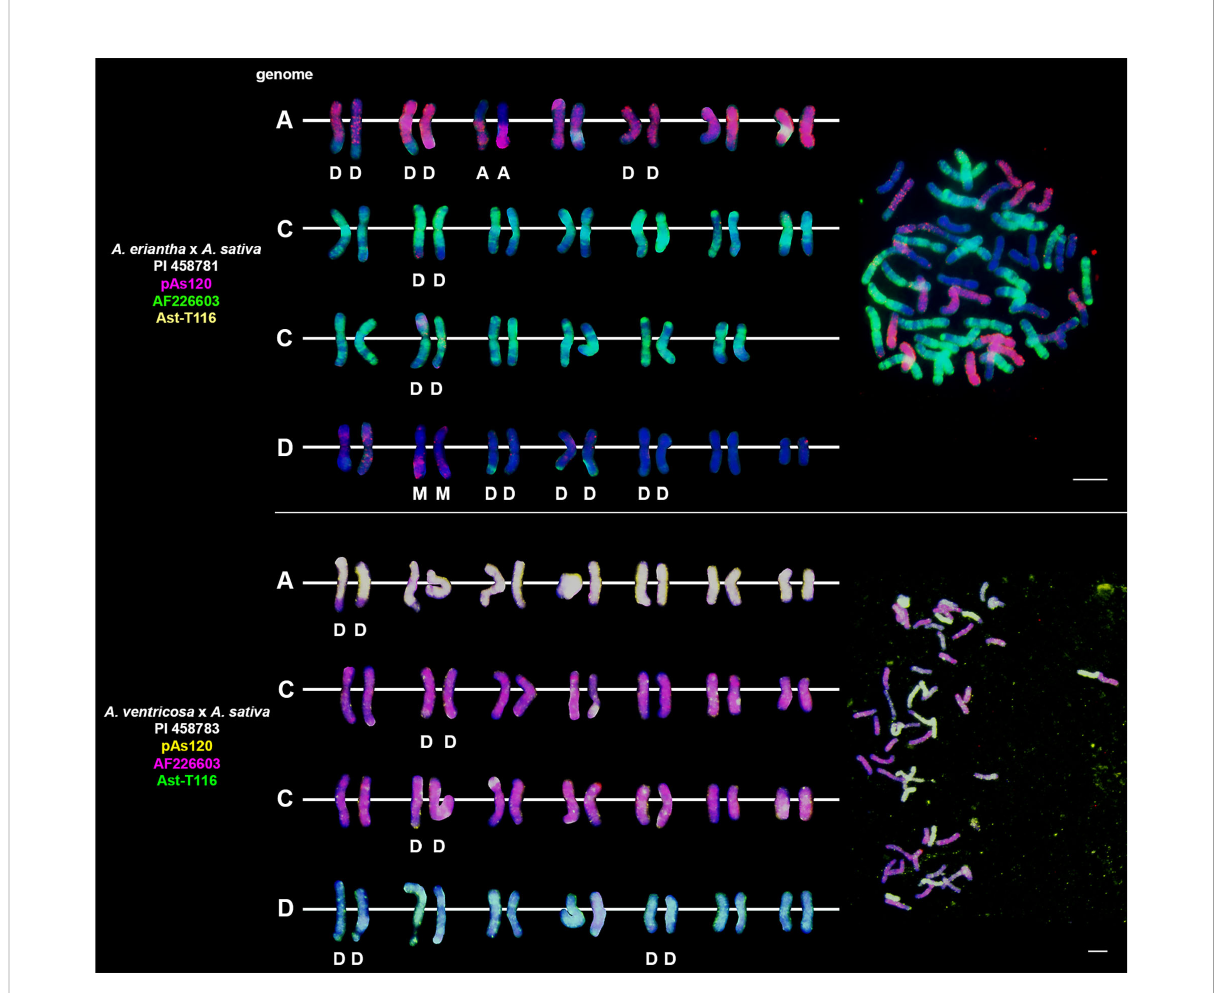
FIGURE 6 Fluorescence in situ hybridization with repetitive DNA probes to chromosomes of amphiploids formed by crossing diploid species having CC genomes with A. sativa . Intergenomic translocations were visualized. D- distal translocation, I- interstitial translocation, M - multiple translocation or insertion. Scale bar = 10 m